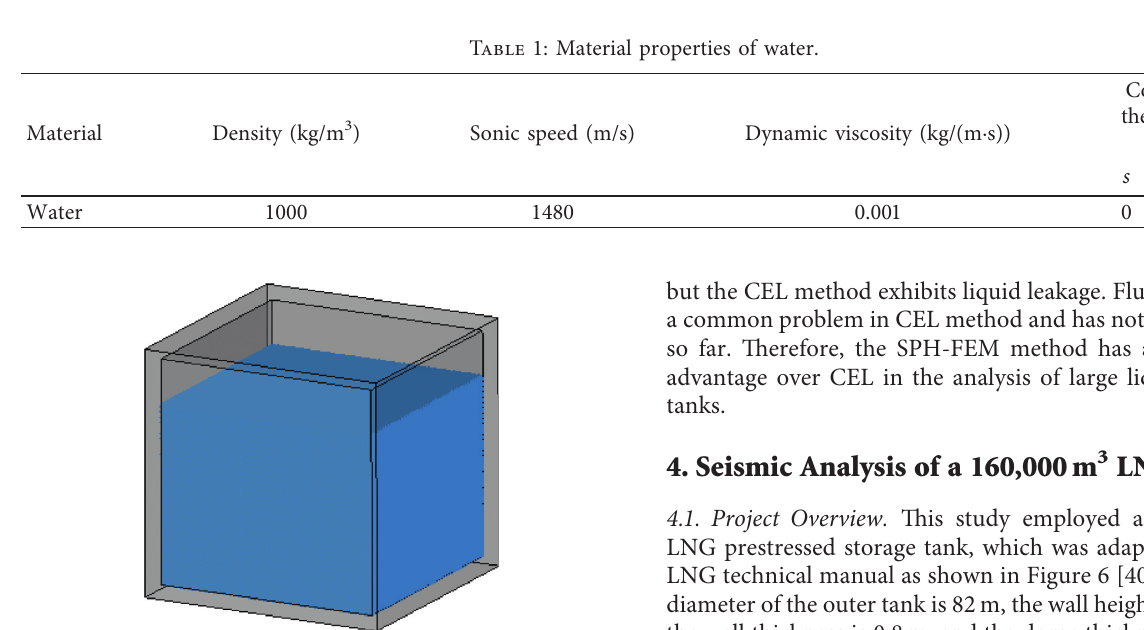
Figure 2: Model for the SPH-FEM algorithm.